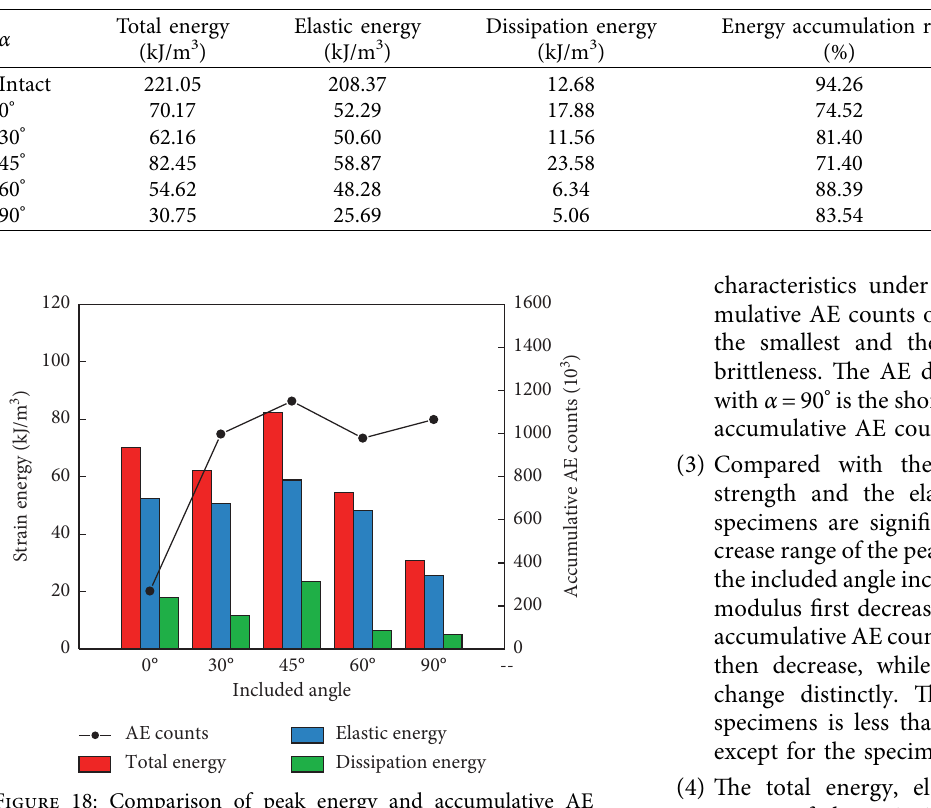
Table 2: Peak energy indexes of the intact and the jointed specimens.